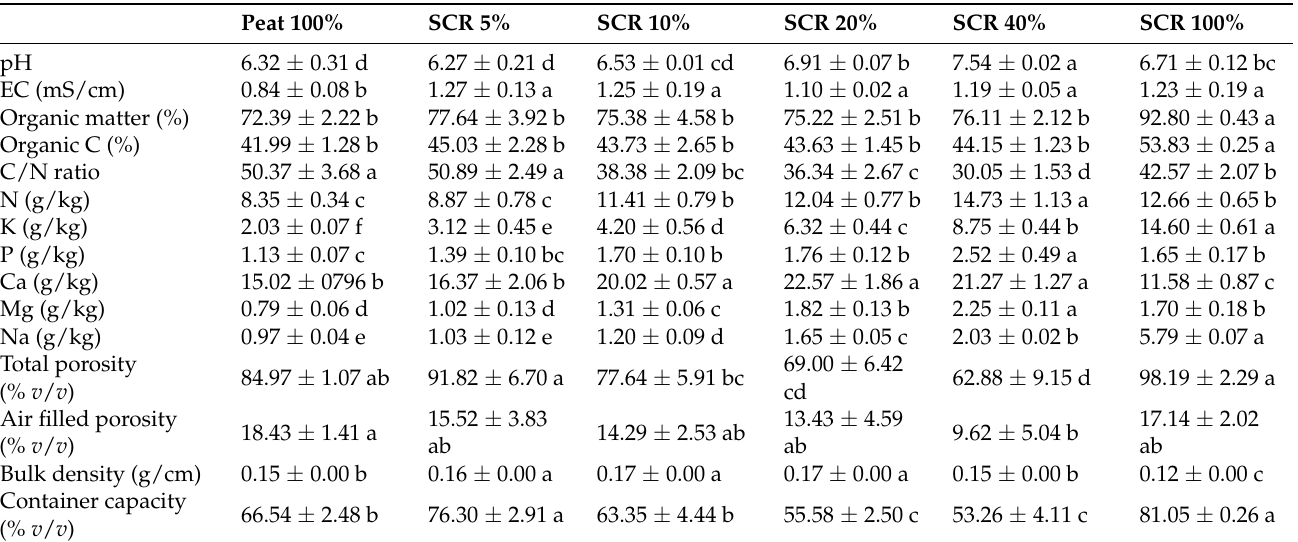
Table 2. Growing media (peat and Sideritis cypria residue (SCR)), showing the mixture’s physico- chemical properties before plant